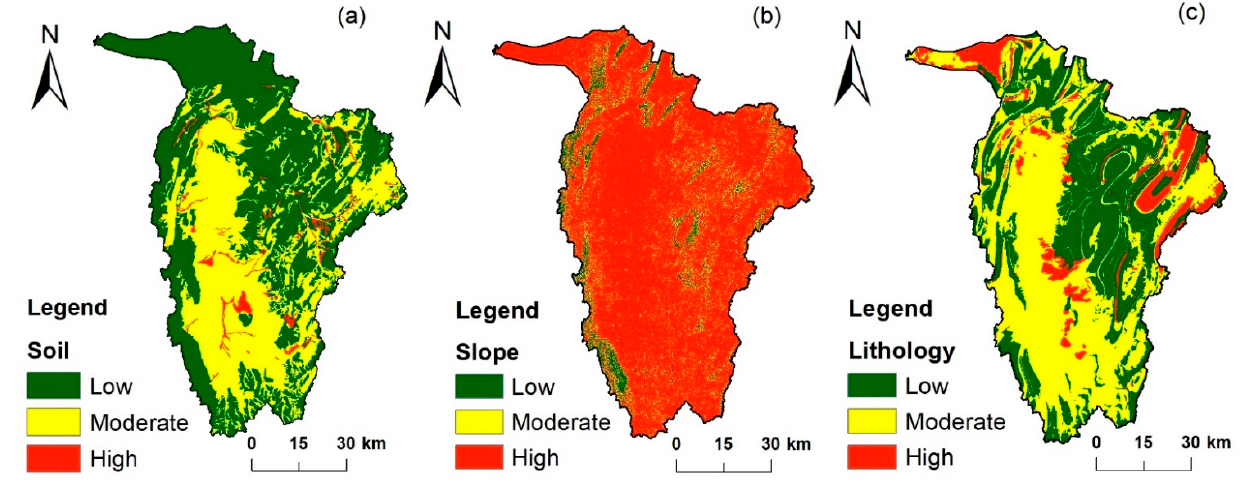
Figure 9. Reclassified thematic layers of ( a ) soil, ( b ) slope, and ( c ) lithology.